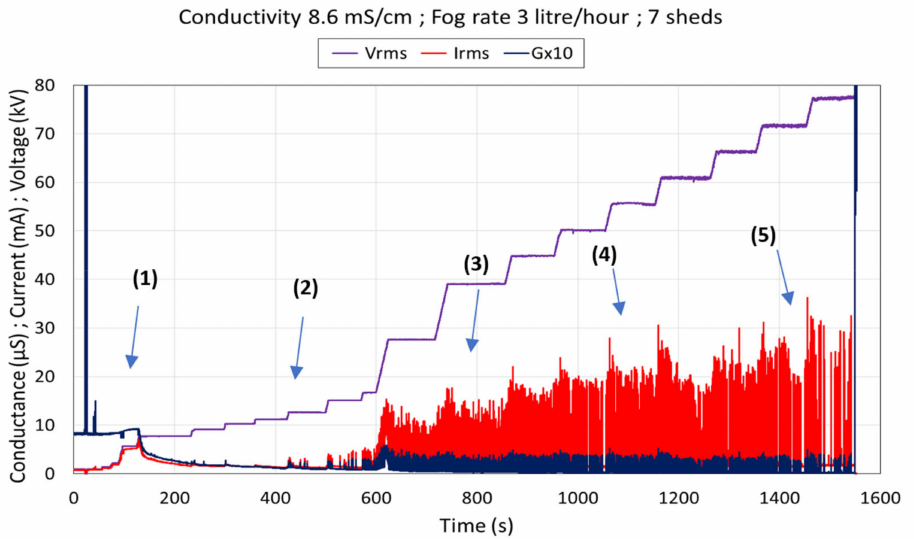
Figure 12. Surface conductance, leakage current, and applied free ramp voltage for heavy pollution. (1), (2) (3), (4) and (5) are areas where Leakage Current (LC) activity and magnitude